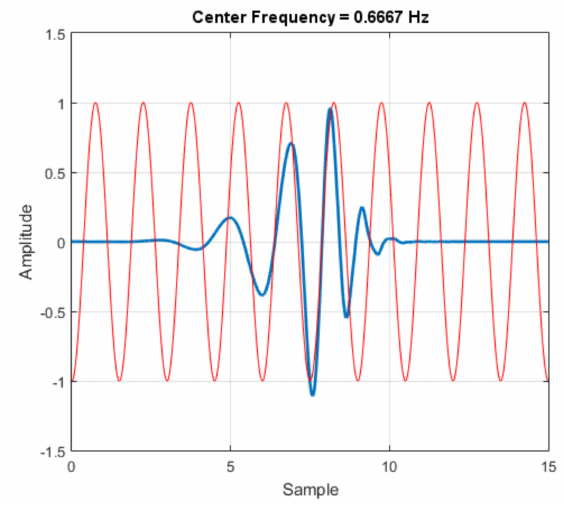
Figure 11. Wavelet (blue) and center frequency-based approximation.